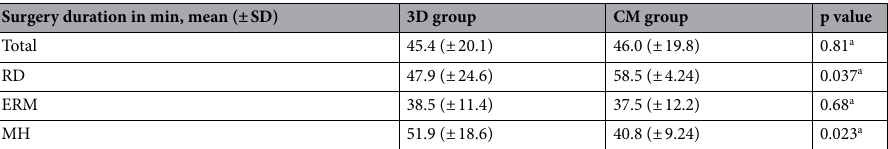
Table 5. Surgery duration according to disease subgroup in the three-dimensional (3D) and conventional microscopy (CM) patient groups. ERM epiretinal membrane, MH macular hole, RD retinal detachment, SD standard deviation. a Welch’s